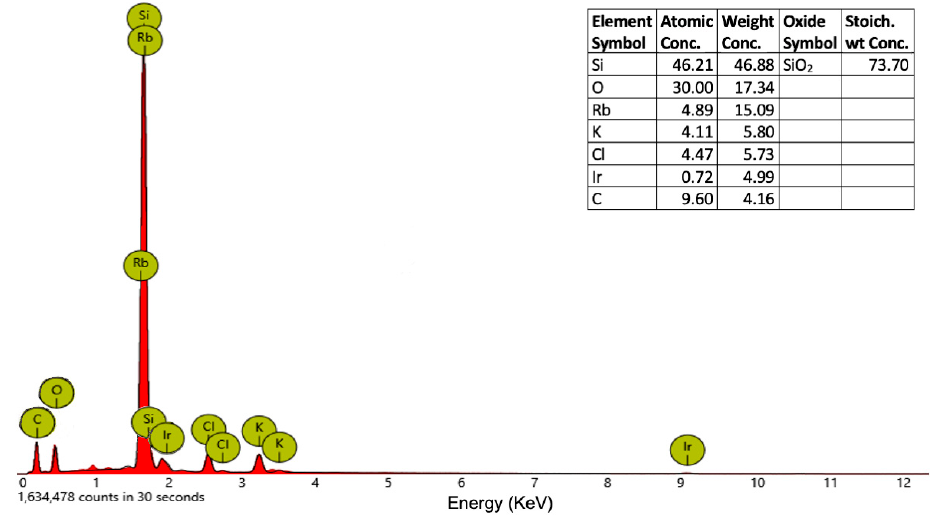
Figure 3. EDX spectrum and elements concentration of Ir-NP2.